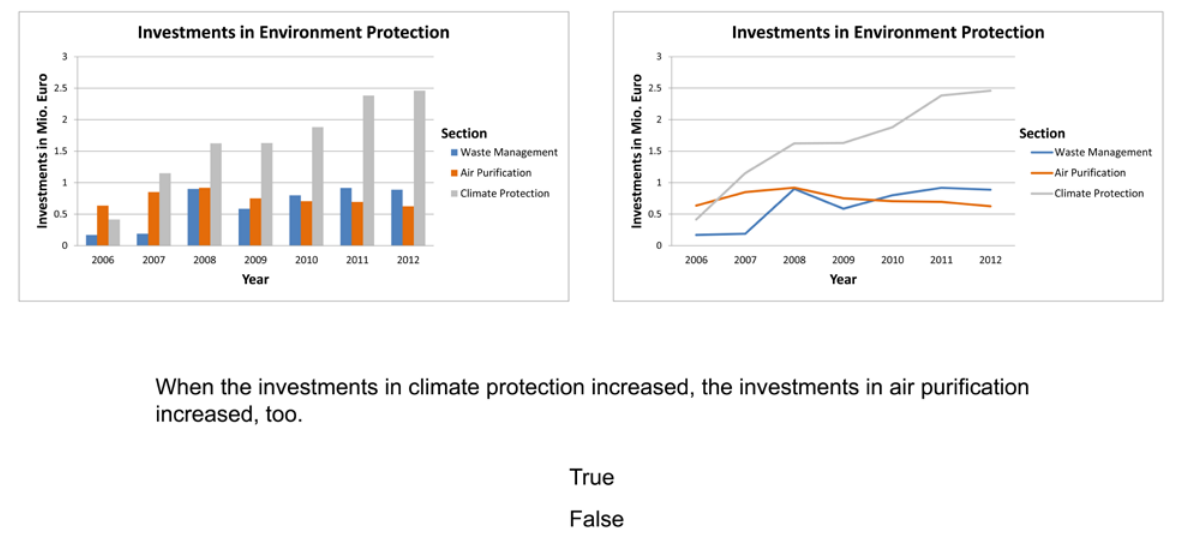
Figure 1 . Sample stimulus of the graph tasks (translated from